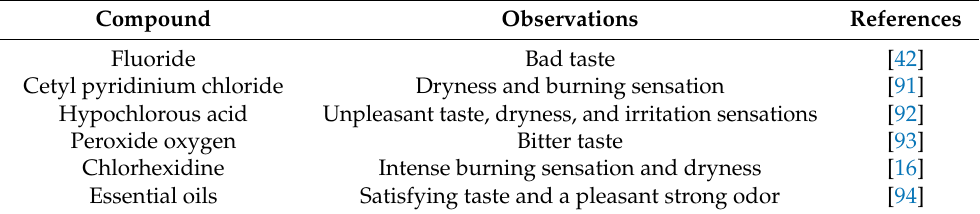
Table 5. Sensory attributes of dental products with different antimicrobials.